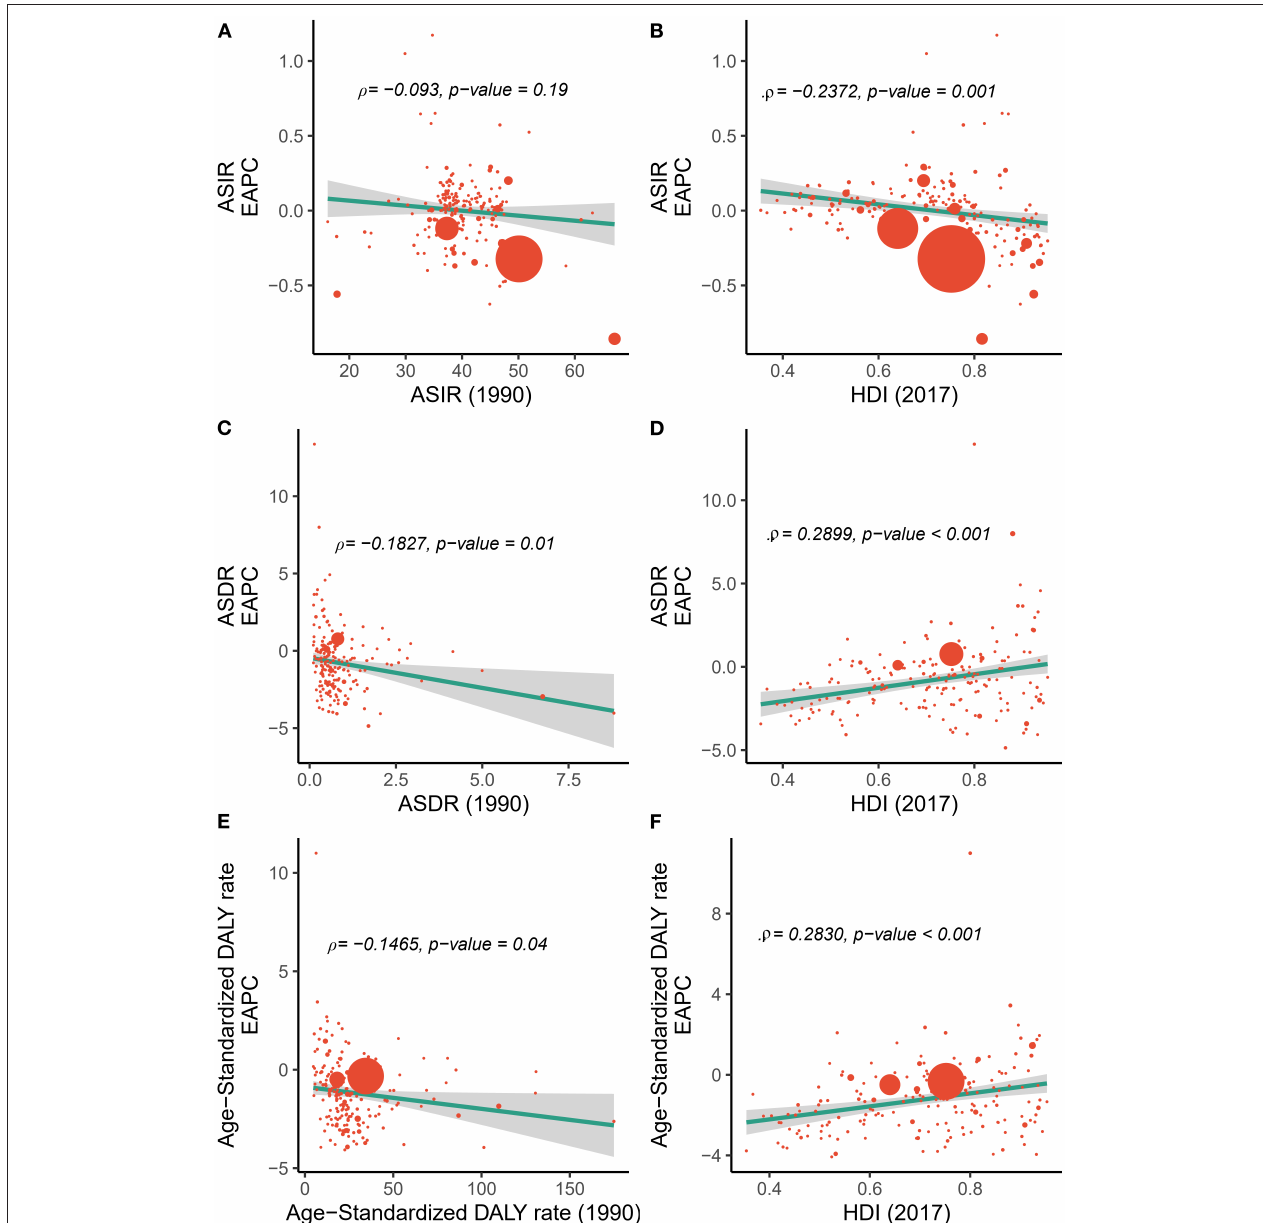
FIGURE 4 | Correlation between the EAPC of incidences/deaths/DALYs and (A,C,E) the corresponding ASRs in 1990 and (B,D,F) HDI in 2017. The size of the circle is increased with the number of incidence, death, and DALY cases of myocarditis. ASR, age-standardized rate; ASIR, age-standardized incidence rate; ASDR, age-standardized death rate; DALY, disability-adjusted life year; EAPC, estimated annual percentage change; HDI, Human Development Index.